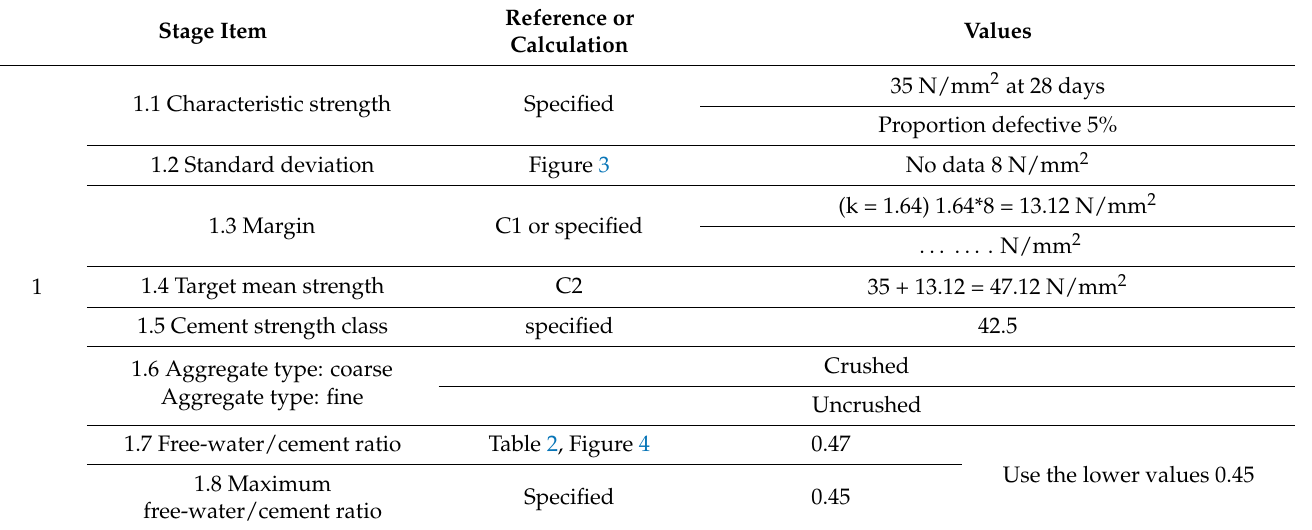
Table A2. Concrete mix design for each material